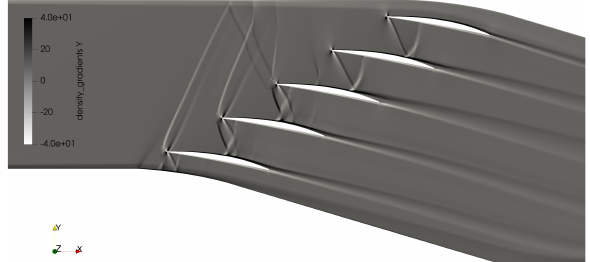
Fig. 7. Contours of the density gradient in y direction ∂ρ /∂y depicting shock waves and wakes behind